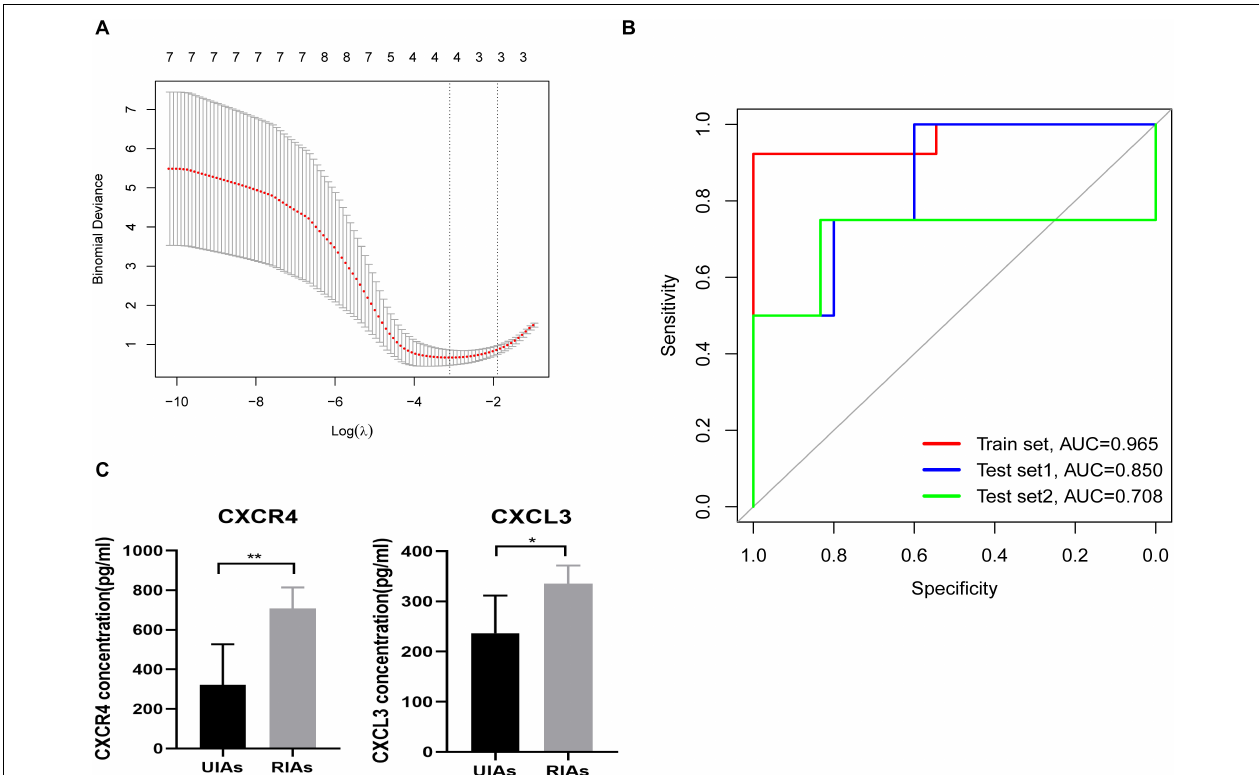
FIGURE 5 | IRMIR construction and ELISA results. (A) The logistic regression model for the training set was conducted to identify an optimum linear combination in predicting responsiveness. (B) The AUC of the training set was 0.965. The AUC of test set 1 was 0.850, and the AUC of test set 2 was 0.708. The red line represents the training set. The blue line represents test set 1, and the green line represents test set 2. (C) CXCR4 and CXCL3 concentrations in the serum of RIA and UIA patients. The CXCR4 ( p < 0.01) and CXCL3 ( p < 0.05) concentration in the serum from RIA patients was significantly higher than that in UIA patients, respectively. IRMIR, immune-related risk model for IA rupture; ELISA, enzyme-linked immunosorbent assay. * represents P < 0 . 05, ** represents P < 0 . 01.